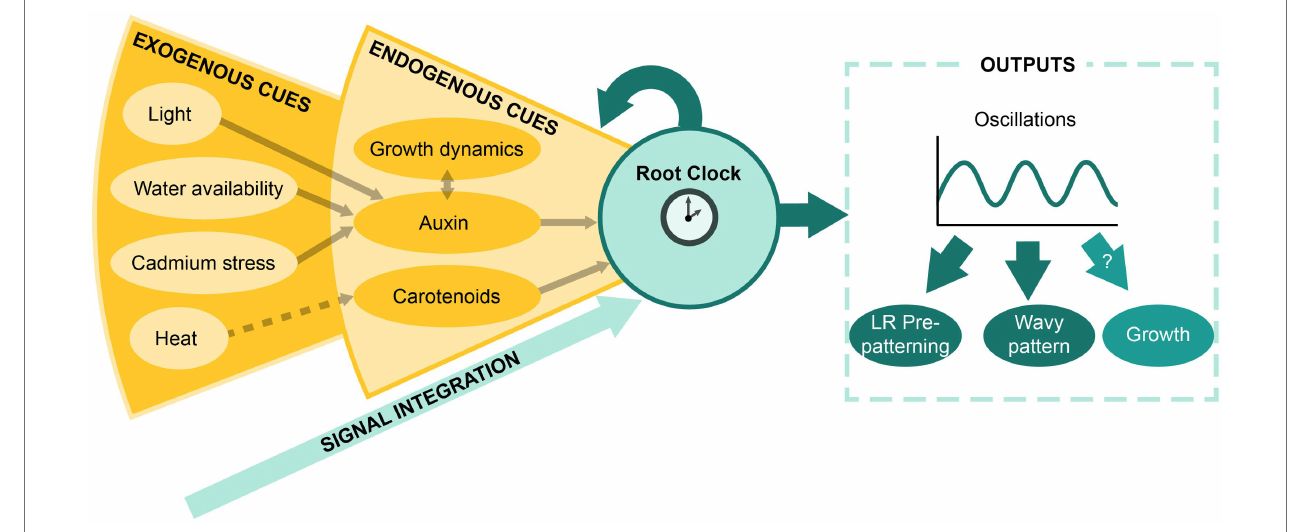
FIGURE 3 | The Root Clock as a signal integrator system. Schematic representation of the model proposed for the integration of exogenous and endogenous signals by the Root Clock and the resulting